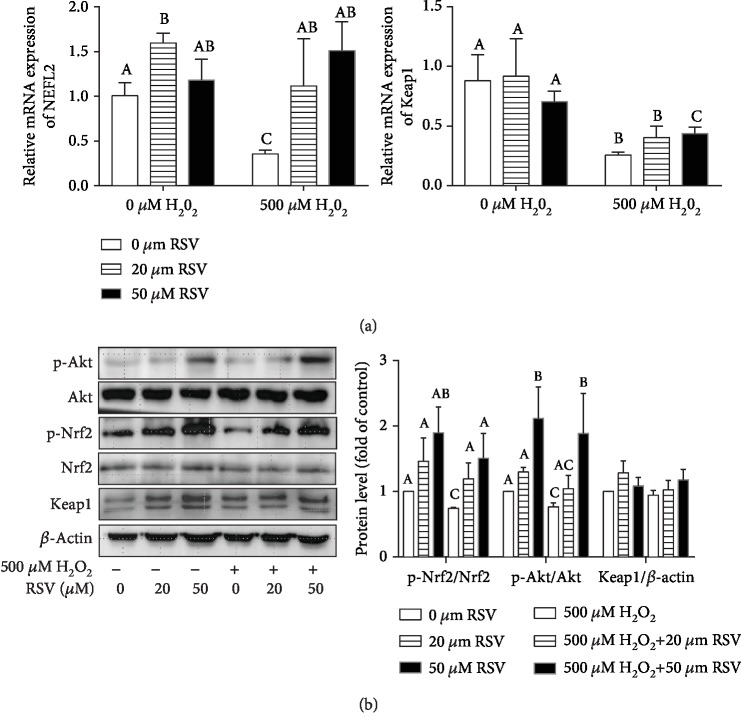
Effects of resveratrol and/or H2O2 on the Akt and Nrf2/Keap1 pathways in IPEC-J2 cells. IPEC-J2 cells were pretreated with the indicated concentrations of RSV for 6 hours and then cocultured with 500 μM H2O2 for 4 hours. (a) The expression of Nrf2 and Keap1 was detected by qRT-PCR. Data are shown as ratios of abundance of target gene transcripts in the treated cells to those in the control cells after normalization to β-actin. (b) Protein levels of Keap1, Nrf2, Akt, p-Nrf2, and p-Akt were detected by Western blot with β-actin as the loading control. (b) The levels of proteins were quantified, and data are presented as the means + SD. The columns with the same superscript capital letters and with different superscript capital letters mean no significant difference (P > 0.05) and significant difference (P < 0.05), respectively.